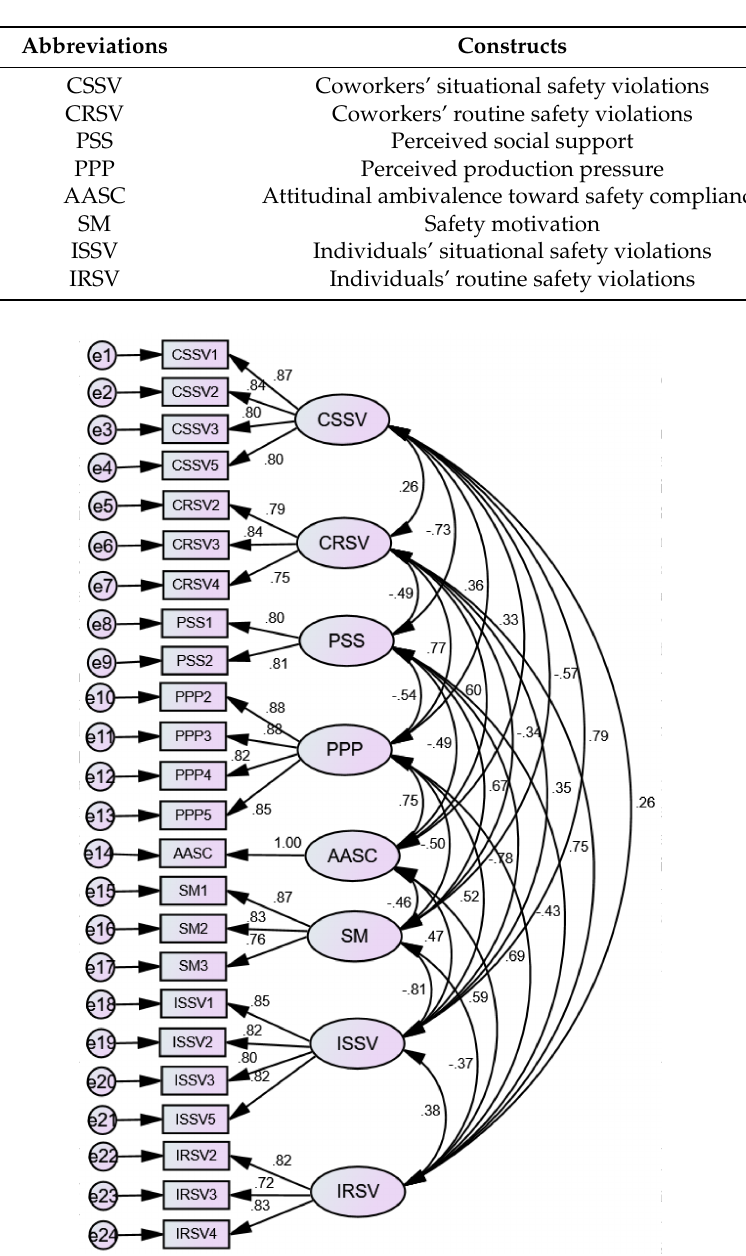
Figure 2. Final measurement model generated by AMOS v21 ( χ 2 IFI = 0.971; RMSEA =